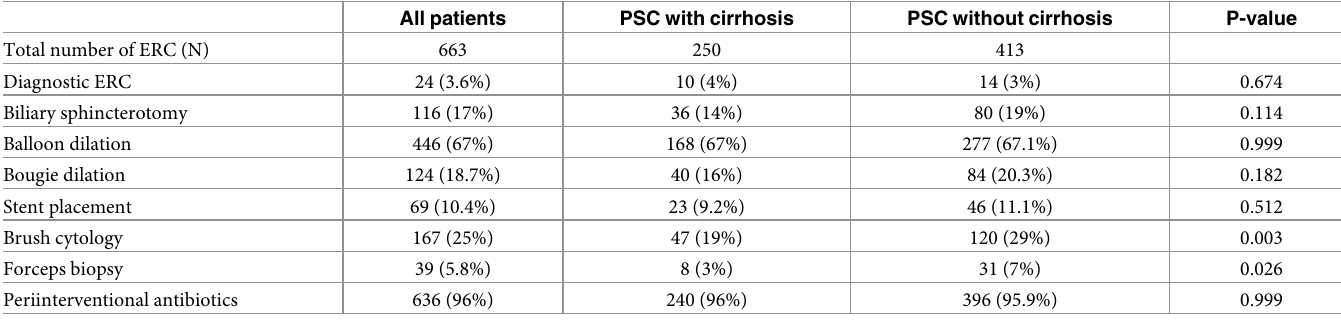
Table 2. Details on ERC